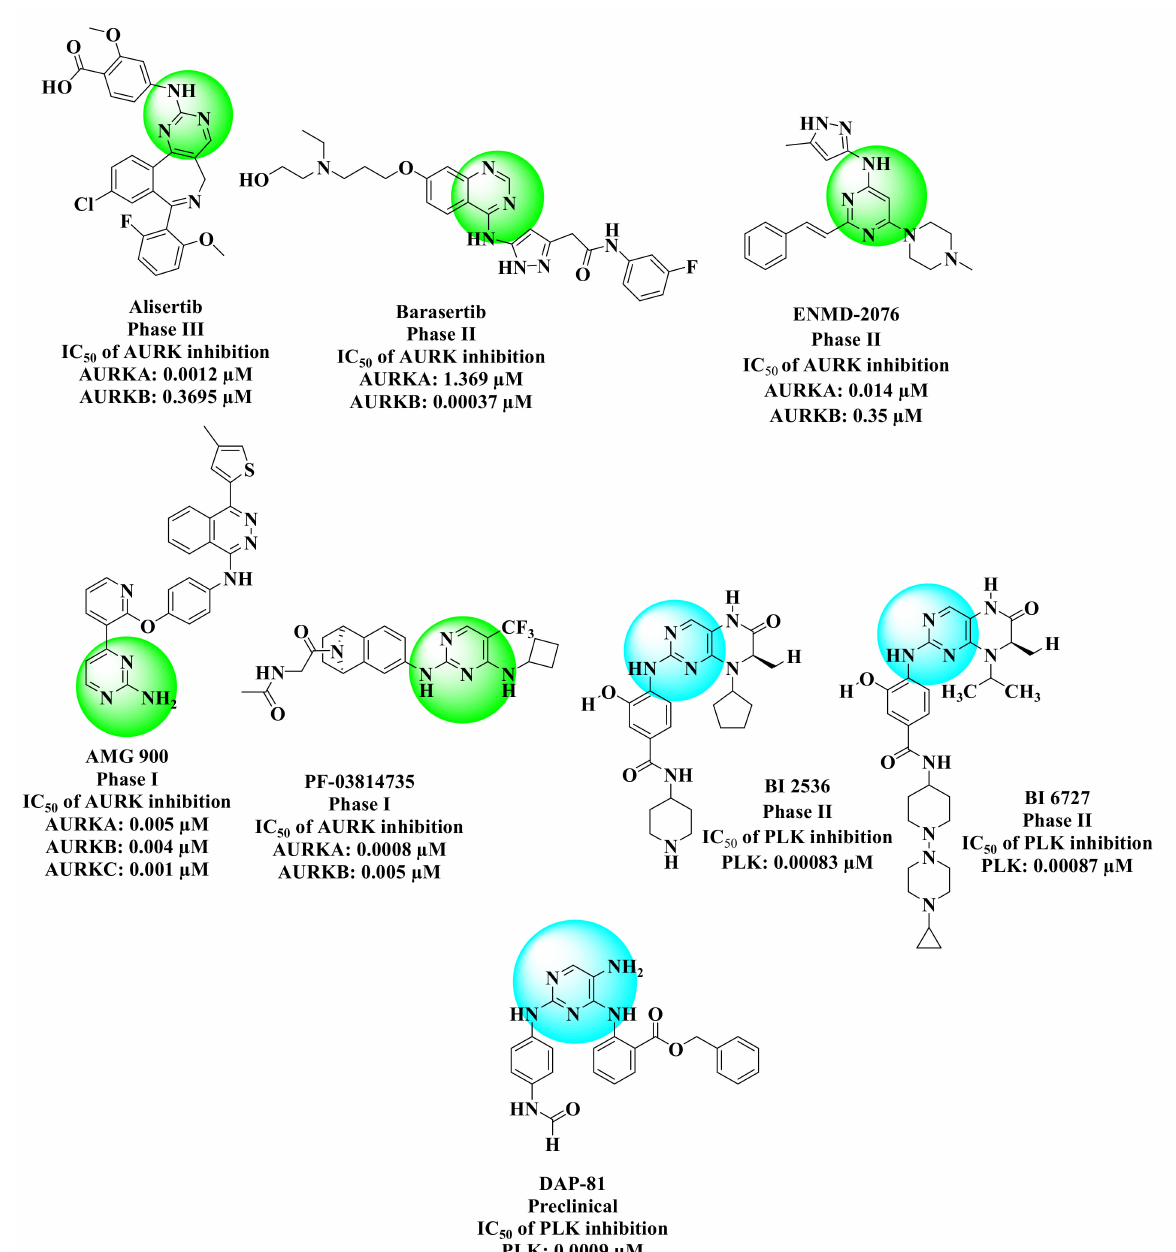
Figure 2. AURK and PLK inhibitors in clinical